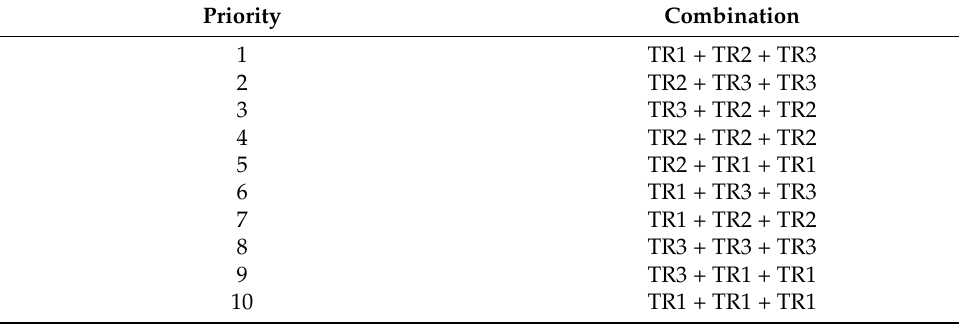
Table 2. Combination table.